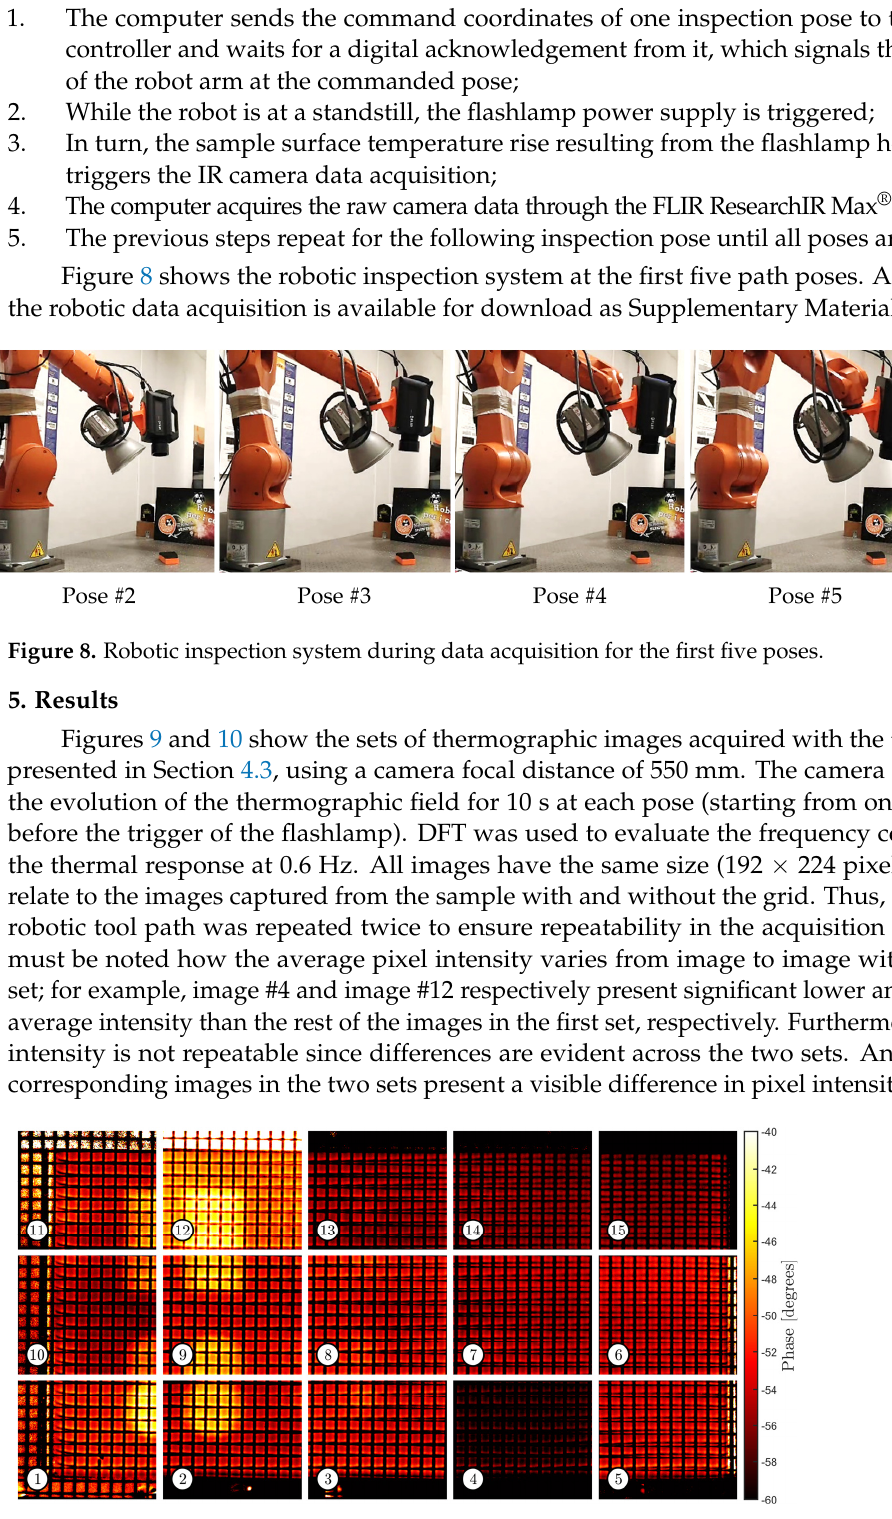
Figure 9. Set of phasegrams taken from the sample with the superposed grid.